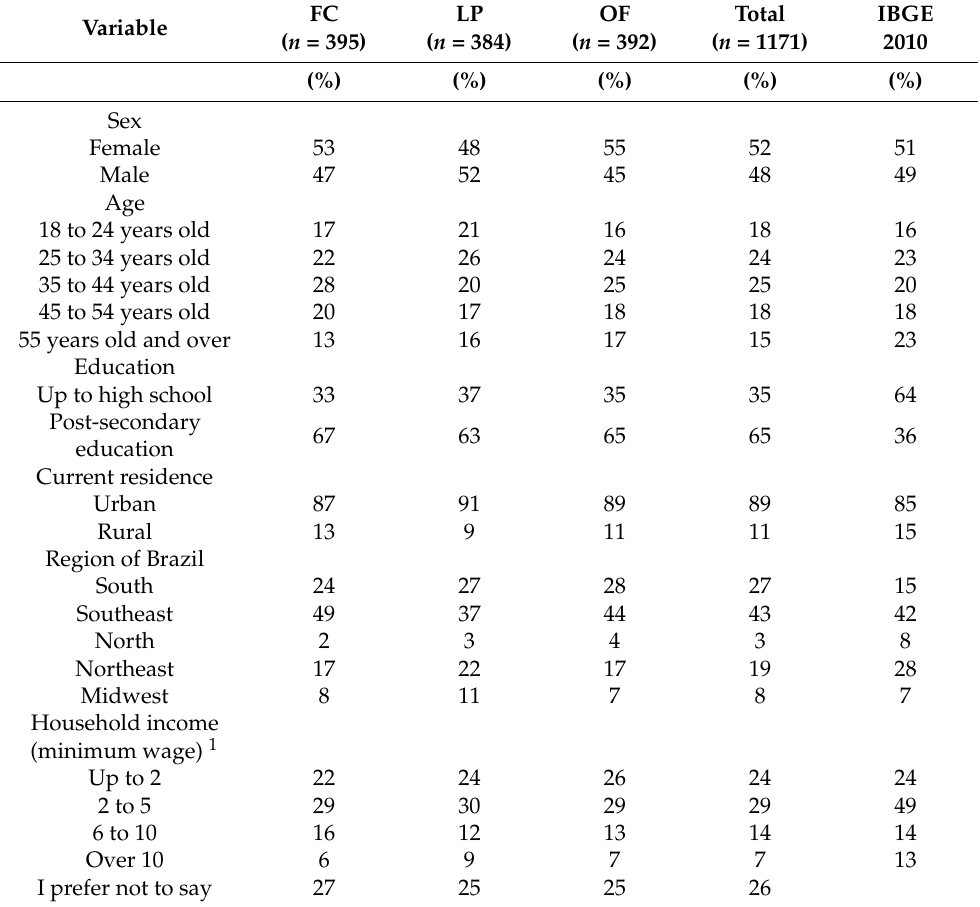
Table 1. Demographics of survey participants ( n = 1171) according to the farrowing system they were assigned to answer about (farrowing crates—FC, loose farrowing pens—LP, and outdoor farrowing—OF) and of the Brazilian population according to latest census (IBGE, [29]).